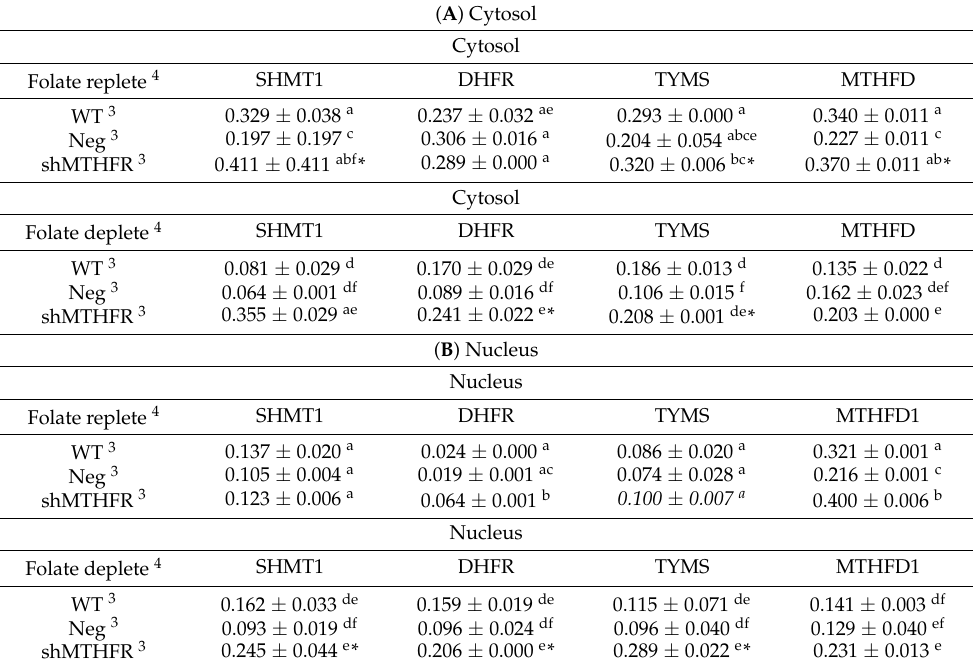
Table 4. shMTHFR enhanced cytosolic and nuclear SHMT/DHFR/TYMS 1 protein expression 2 in HepG2 cells.